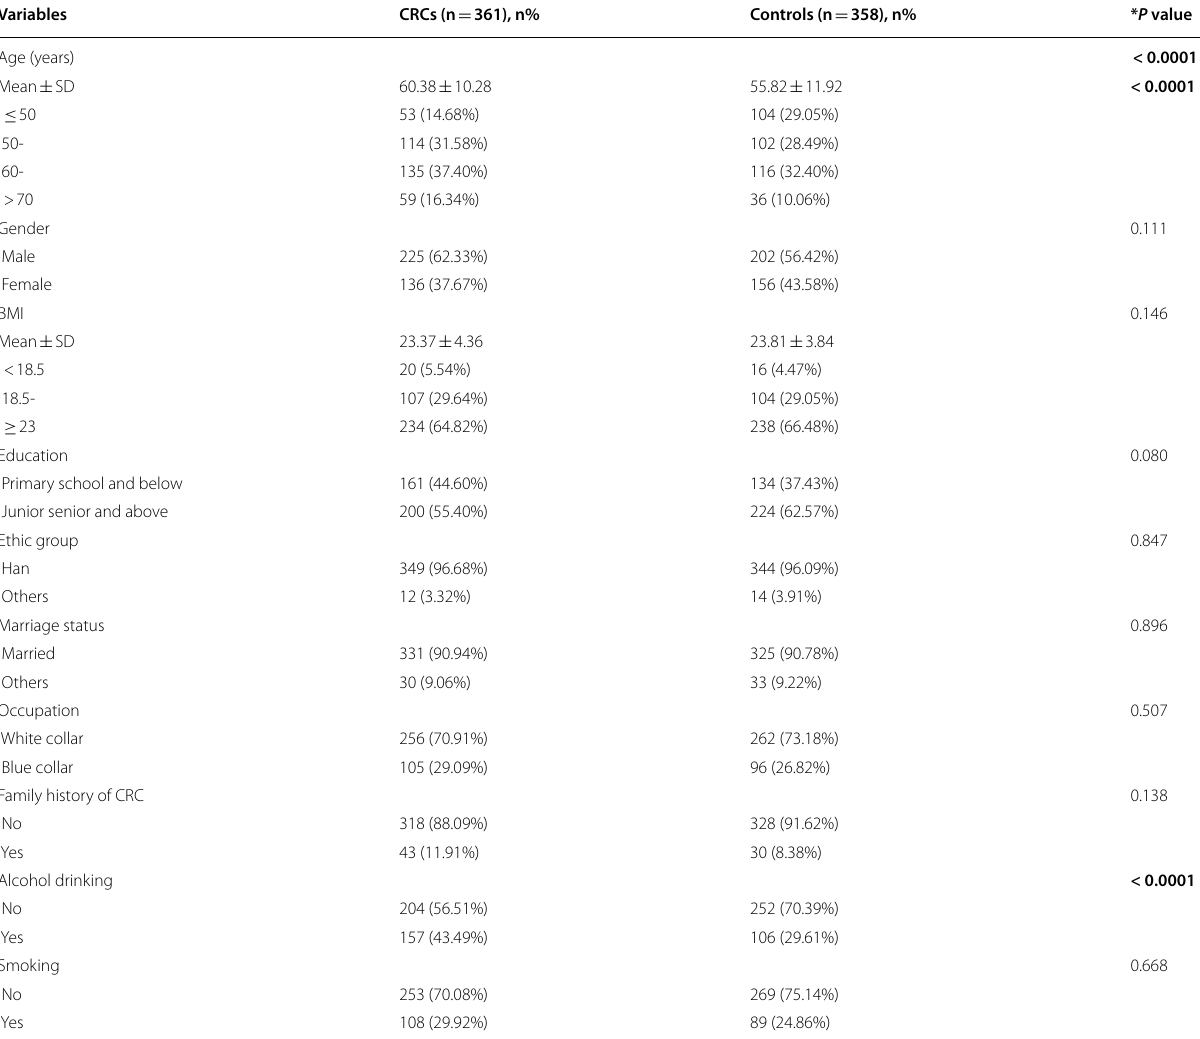
* P values < 0.05 were considered statistically significant and were indicated in bold CRC, colorectal cancer; SD, standard deviation; BMI, body mass index